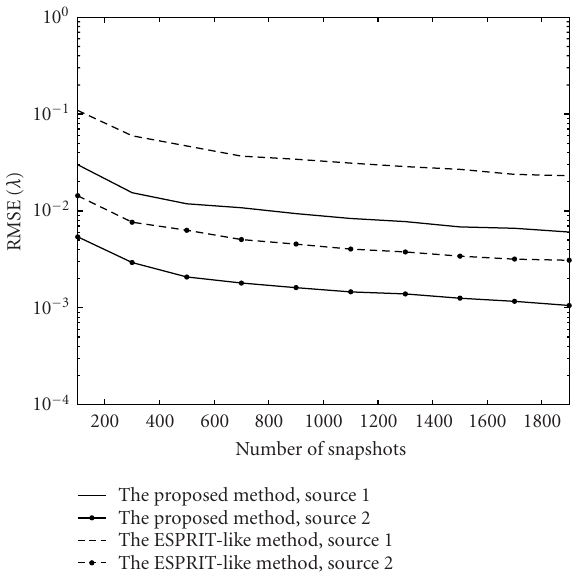
Figure 6: The RMSE of the estimated frequency over 500 Monte Carlo runs versus the number of snapshots; 14 sensors are used and the SNR is fixed at 15dB. Two equi-power sources approach the ar- ray from 38 ◦ and 20 ◦ ,